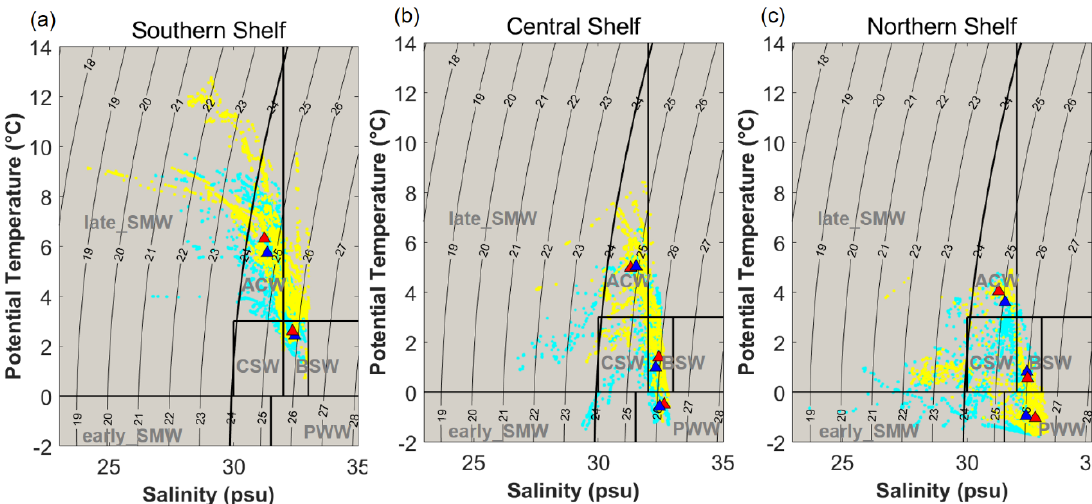
Figure 9. T–S diagrams of ( a ) southern, ( b ) central and ( c ) northern shelf. The light blue and yellow dots belong to the pre- and post-1997 periods, respectively; blue and red solid triangles denote the mean values of the water masses of the pre- and post-1997 periods, respectively.